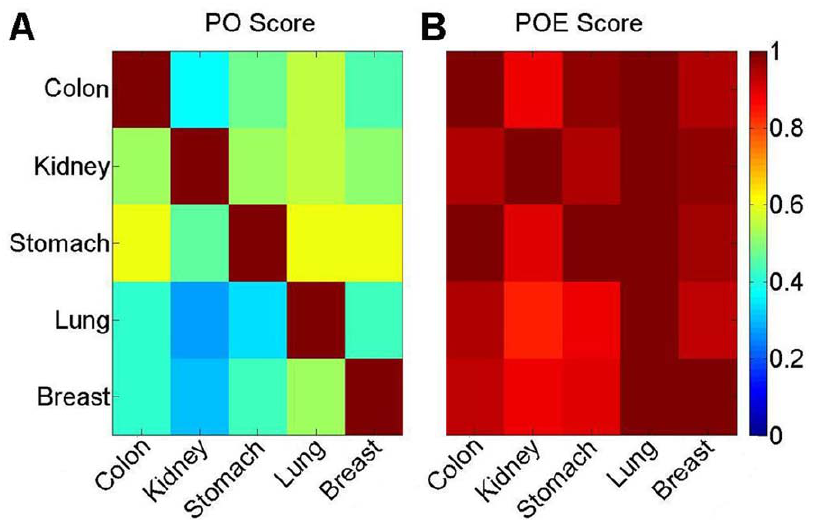
Figure 2. Functional consistency between hypermethylated terms from different cancer types with PO and POE scores. (A) The PO scores of the hypermethylated genes from different cancer types. (B) The POE scores of the hypermethylated genes from different cancer types. Each row represents the scores between the hypermethylated terms for one cancer type and the hypermethylated terms for the other cancer types. A POE score of 1 is shown in red and 0 is indicated in blue.